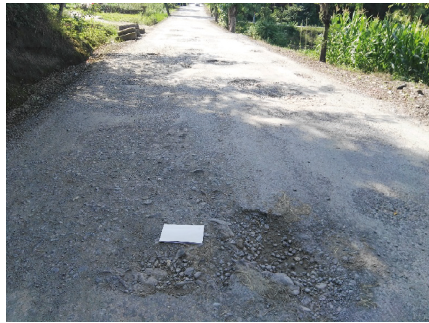
Figure 23: Typical pothole in test section in May 2017.